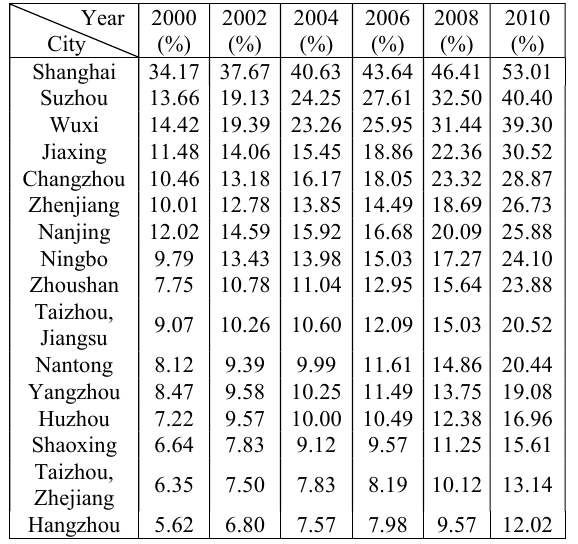
Table 3 . Average light intensity table of each city.